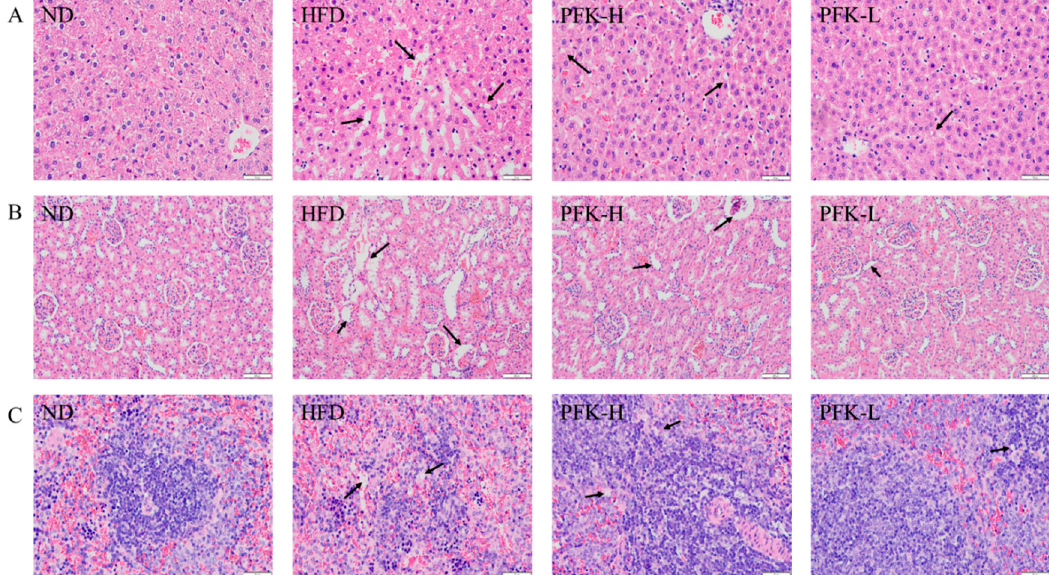
Figure 5. H and E staining of tissue. ( A ) Liver, ( B ) kidney, ( C ) spleen. ND group: normal diet + 0.5% CMC-Na; HFD group: high-fat diet + 0.5% CMC-Na; PFK-H group: high-fat diet + 400 mg/kg krill oil, 40 mg/kg fucoxanthin, 200 mg/kg phycobiliprotein; PFK-L group: high-fat diet + 100 mg/kg krill oil, 10 mg/kg fucoxanthin, 50 mg/kg phycobiliprotein.